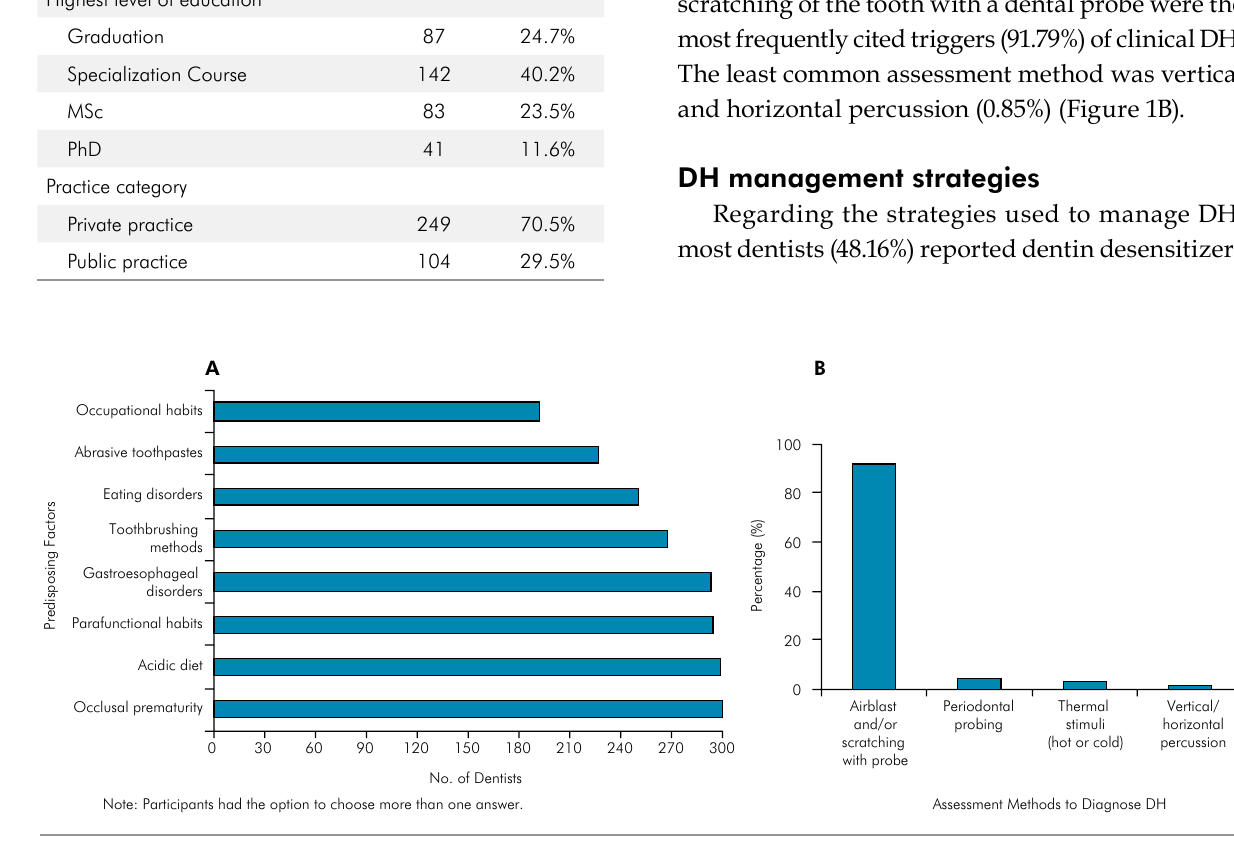
Figure 1. A. Most frequent DH predisposing factors, according to respondents. B. Assessment methods used to diagnose DH, as indicated by the